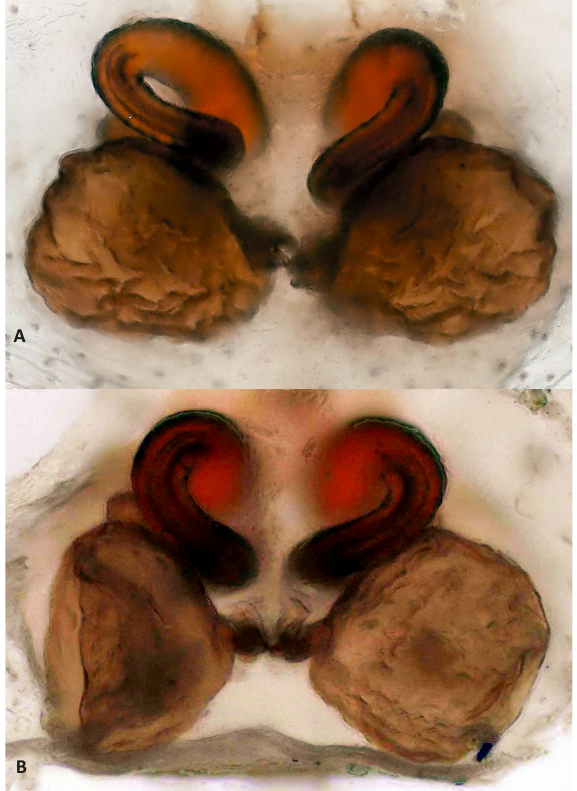
Figure 1. Thomisus telanganaensis sp. nov. epigyne, dorsal view line drawing showing deflated-balloon like spermathecae (Sp), short intromittent canal (IC), and beak-like protruberances of spermathecae (Bp). A - Holotype; B